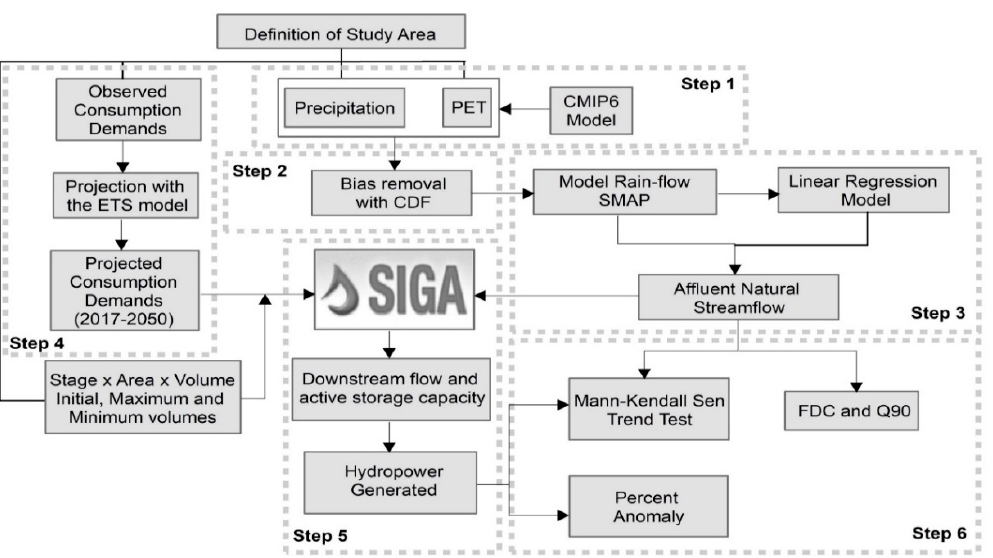
Figure 1. Flowchart of the methodological stages.